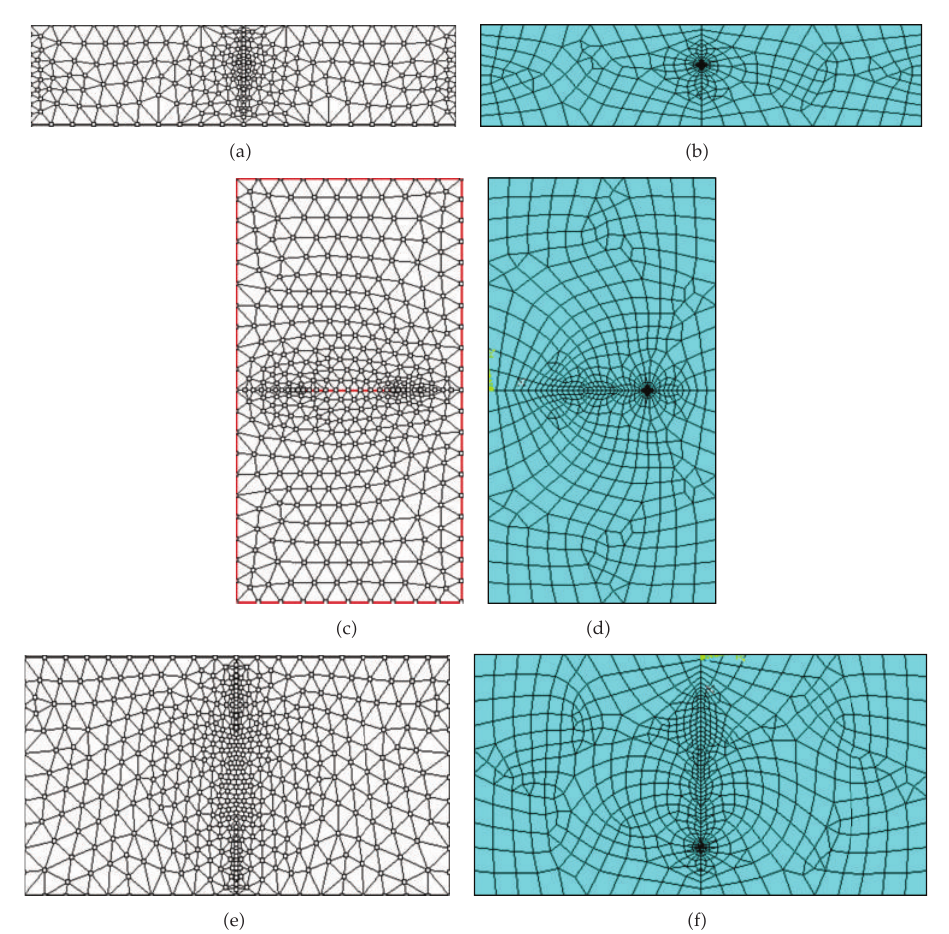
Figure 9: Scattered nodes and triangular background cells (cid:2) left hand side (cid:3) and finite element mesh (cid:2) right hand side (cid:3) for uniform surface loaded specimens with a/W (cid:11) 0 .